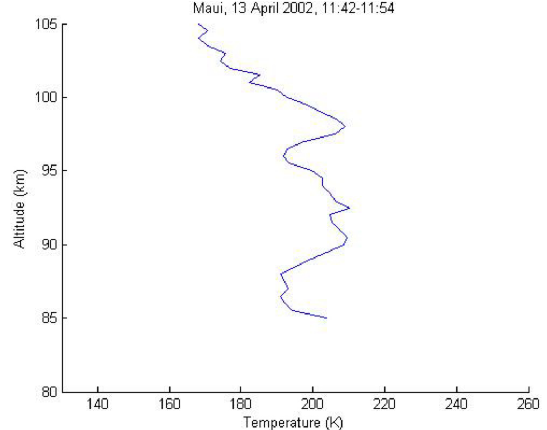
Fig. 3. Temperature profile averaged for about 15min during the overturning event on 13 April